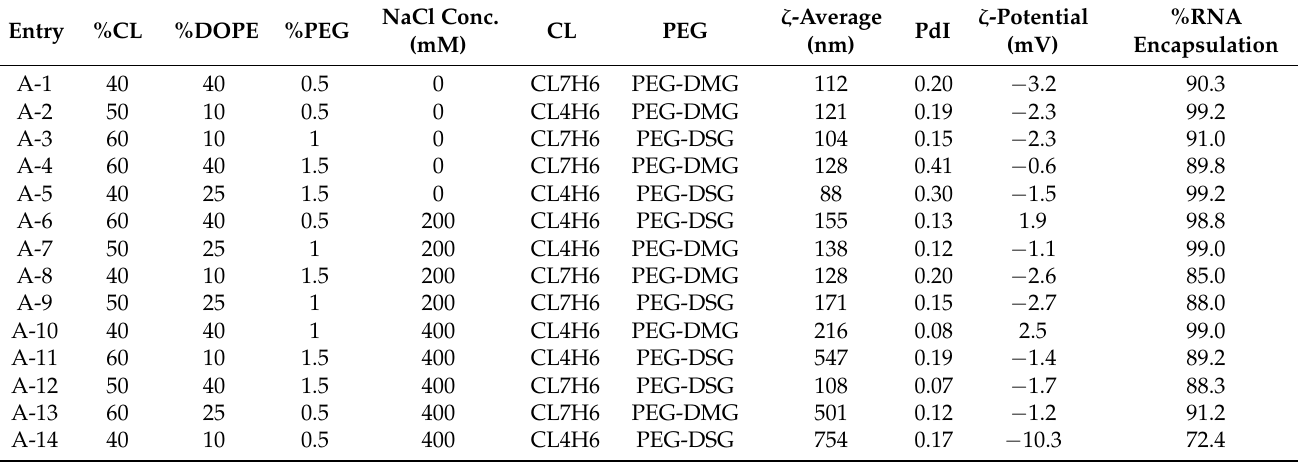
Table 1. Physicochemical properties of the LNPs examined in screening